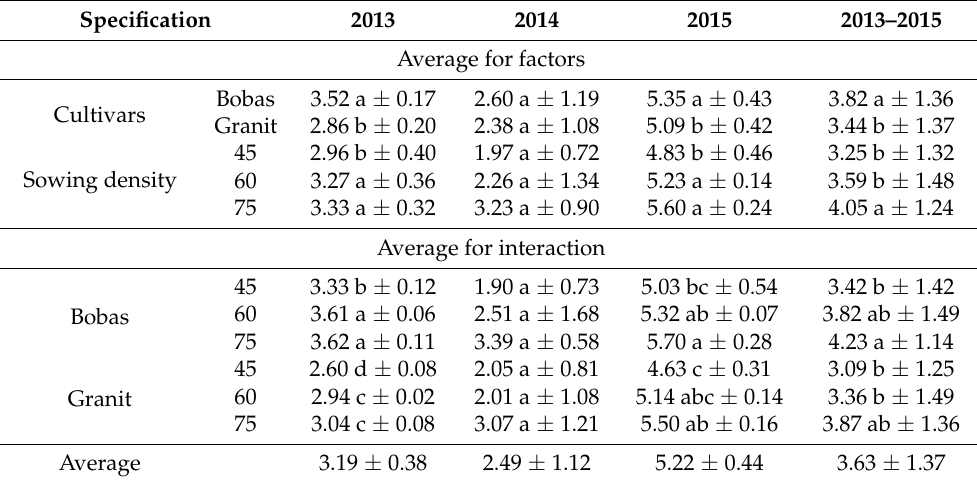
Table 12. Magnesium accumulation in the faba bean seeds (kg ha − 1 ) as influenced by the examined factors during the study years 2013–2015.